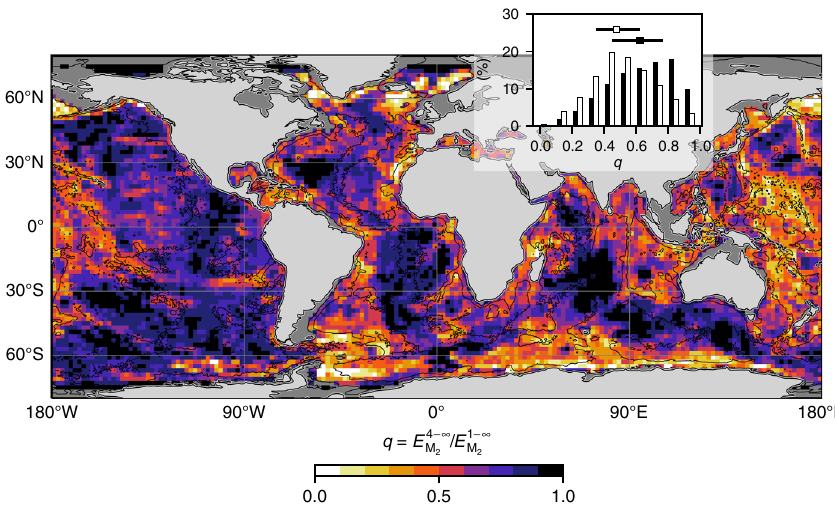
= E 1 (cid:1)1 , and is binned in 2° × 2° M 2 M 2 binned as a function of q , and error bars M 2